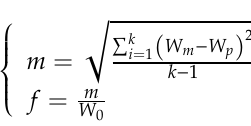
Table 1. Surface subsidence monitoring data of z38, z41, z44, and z47.